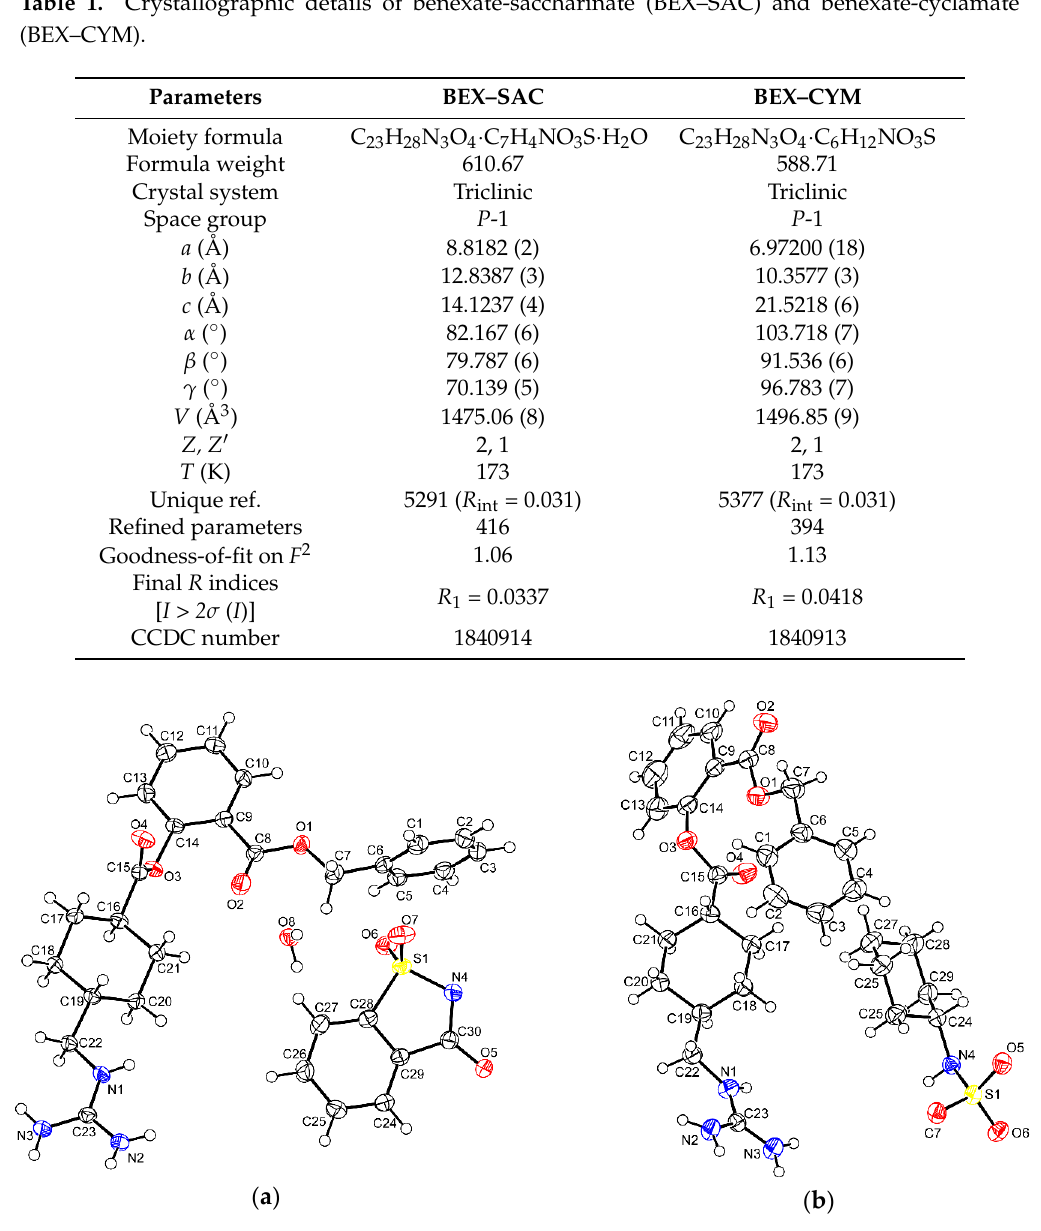
Figure 3. Thermal ellipsoid figures of ( a ) BEX – SAC and ( b ) BEX – CYM are drawn at the 50% probability level. The asymmetric unit of BEX – SAC contained a cationic benexate, an anionic saccharinate, and a water molecule. The asymmetric unit of BEX – CYM contained one cationic benexate molecule and one anionic cyclamate molecule. Table 1. Crystallographic details of benexate-saccharinate (BEX – SAC) and